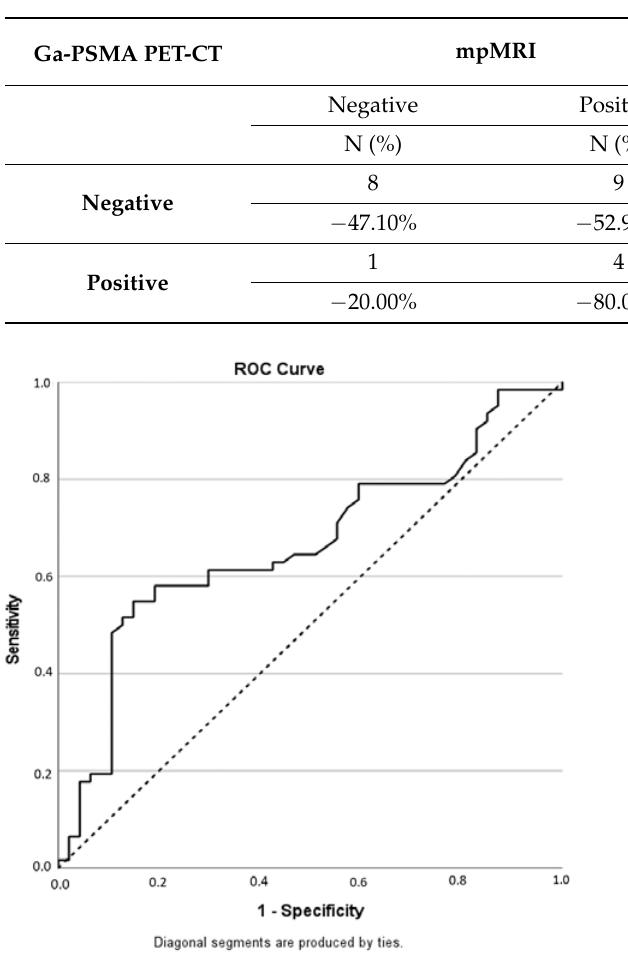
(42.1%) had a PI-RR score ≥ 3 at mpMRI.